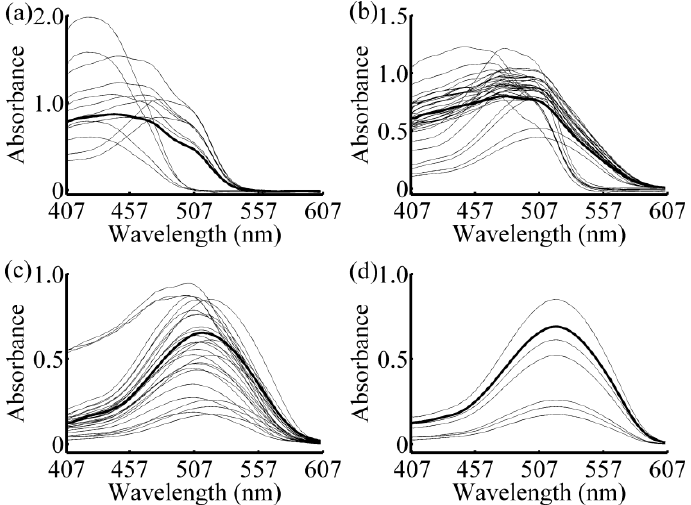
Figure 4. Absorption spectra of calibration subset. ( a ) two-component sample 1 (tartrazine: 60 μg/mL, sunset yellow FCF: 50 μg/mL); ( b ) four-component sample (amaranth: 50 μg/mL, carmine: 60 μg/mL, tartrazine: 40 μg/mL, sunset yellow FCF: 30 μg/mL); ( c ) two-component sample 2 (amaranth: 100 μg/mL, carmine: 50 μg/mL); and ( d ) one-component sample (amaranth: 160 μg/mL).